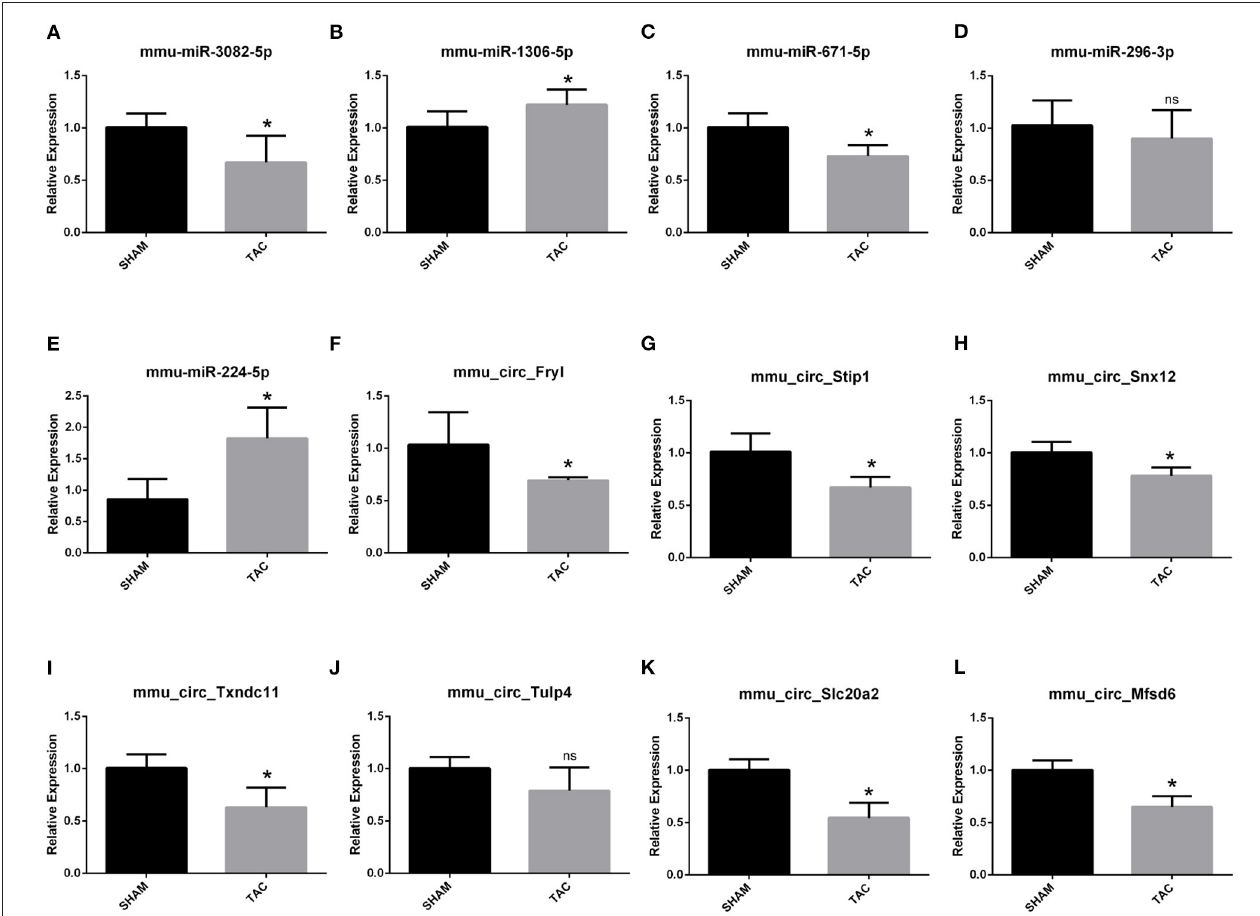
FIGURE 6 | QRT-PCR validation of the differentially expressed circRNAs and miRNAs. The expression results of miRNAs (A–E) and circRNAs (F–L) . * P < 0.05; ns, non-significant.